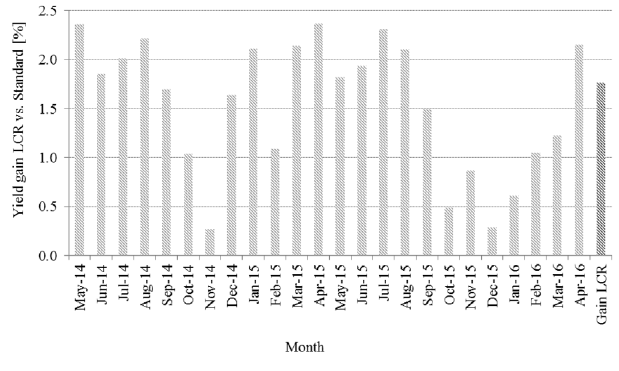
Fig. 12. Comparison of a module set over months – yield gain LCR against standard